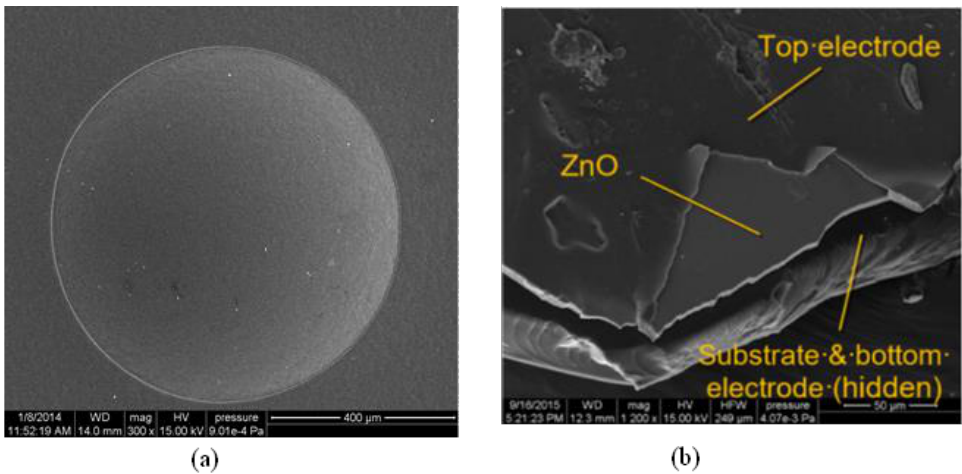
Figure 7. SEM images of the ZnO piezoelectric film self-focusing ultrasonic transducer ( a ) spherical cap and ( b ) ZnO film and electrode.